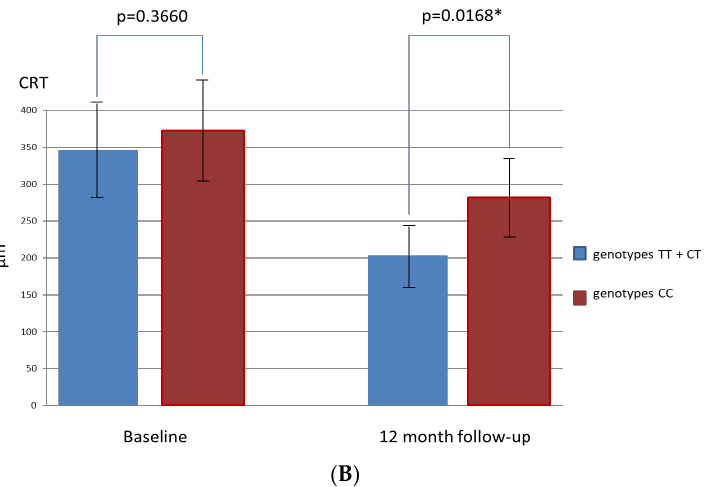
Figure 1. Changes in best corrected visual acuity (BCVA) ( A ) and central retinal thickness (CRT) ( B ) in patients with TT and CT genotypes for single nucleotide polymorphism rs1061170 of the CFH gene in comparison with patients with the CC genotype (* significant p -value < 0.05).